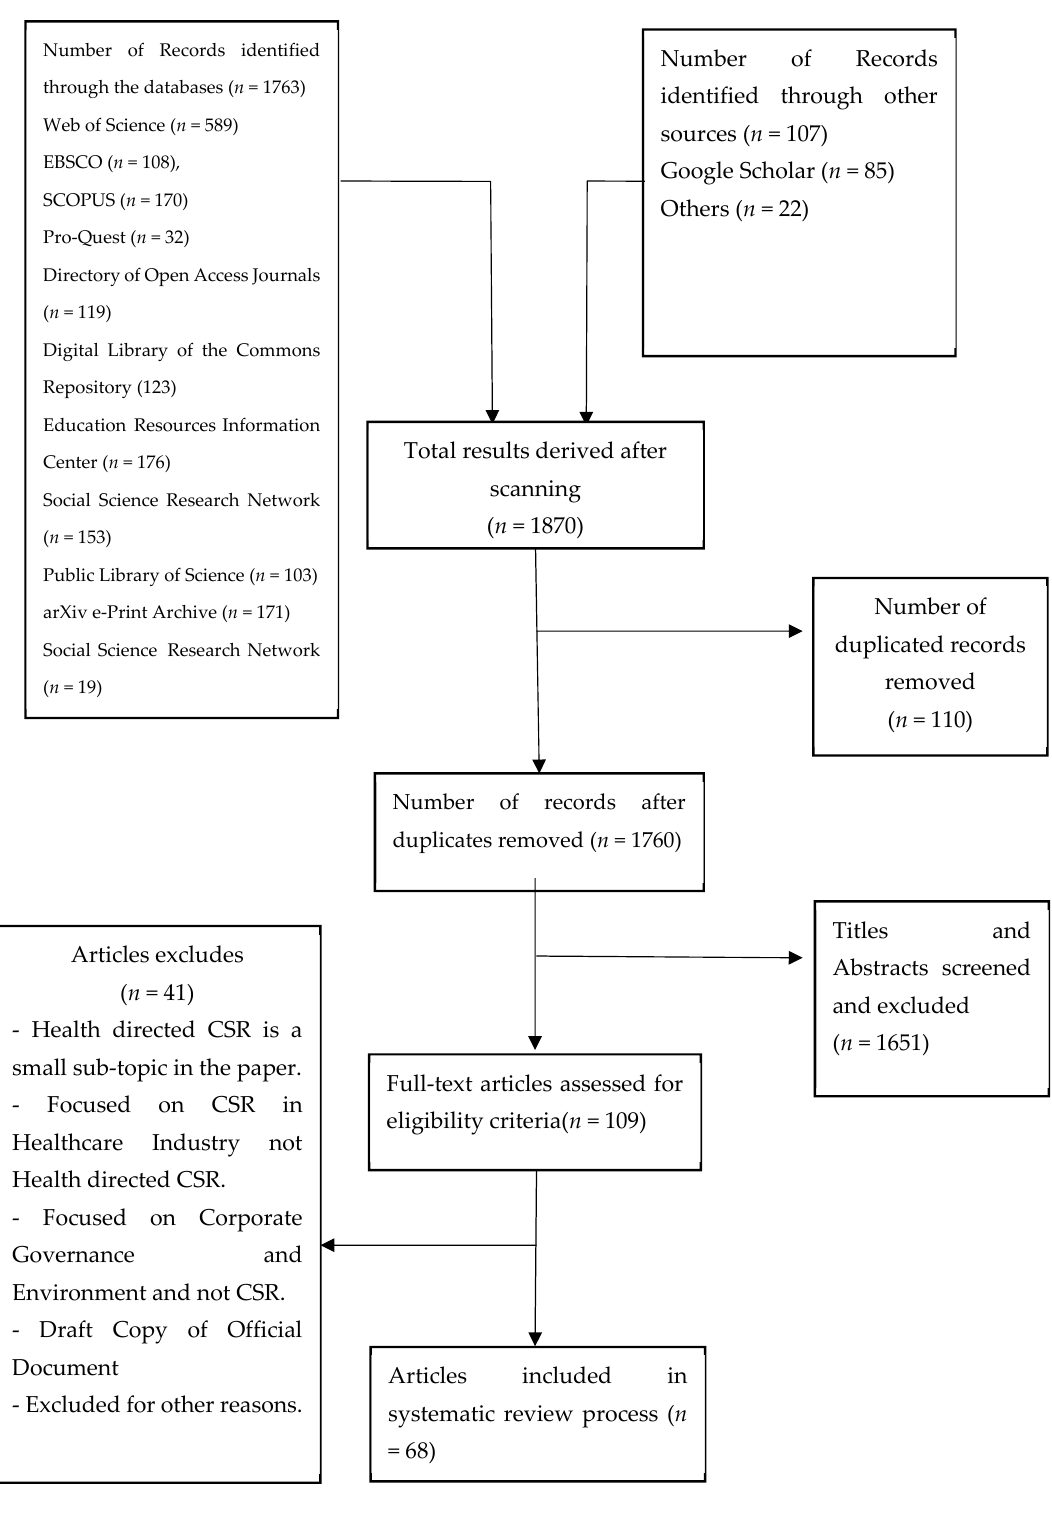
Figure 1. PRISMA Figure 1. PRISMA model.